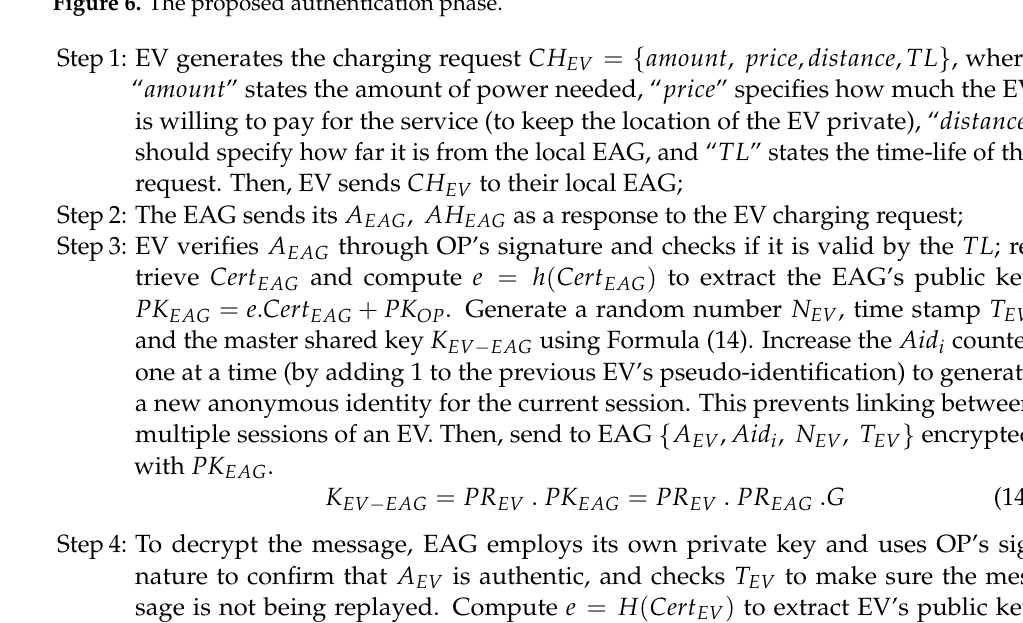
Figure 6. The proposed authentication phase.